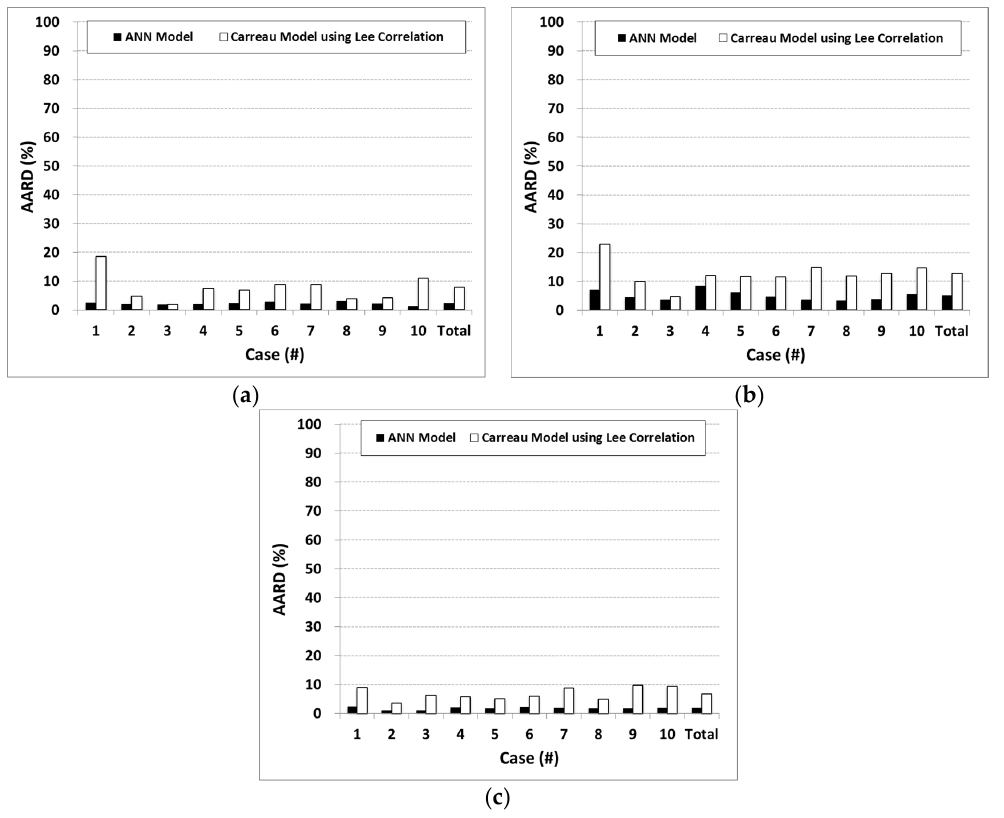
Figure 11. Average absolute relative deviation (AARD) of the viscosity estimated by the ANN model and by the Carreau model using Lee’s correlation. ( a ) Flopaam TM 3330S. ( b ) Flopaam TM 3630S. ( c ) AN ‐ 125.